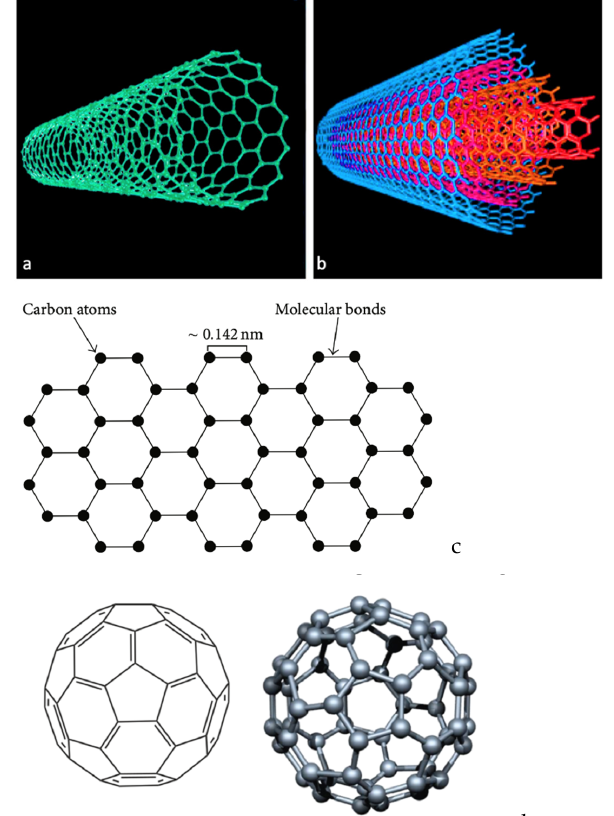
Figure 7. Carbon-based nano-additives. Three-dimensional presentation of ( a ) SWCNTs and ( b ) MWCNTs [110]; ( c ) schematic representation of a graphene sheet [111] and ( d ) 2D and 3D illustration of the fullerene C60 structure [112].